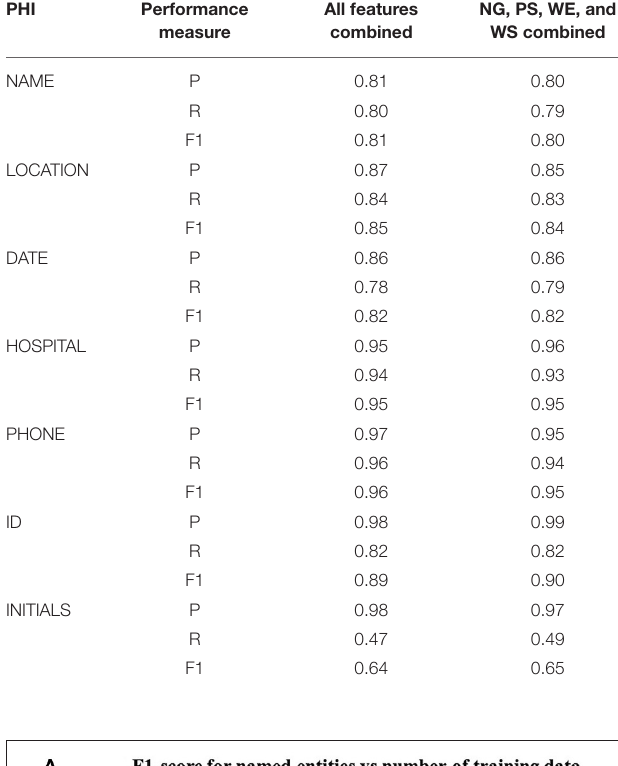
TABLE 2 | Precision, Recall, and F1-score achieved by the models trained by all the features and four of the best performing features. PHI